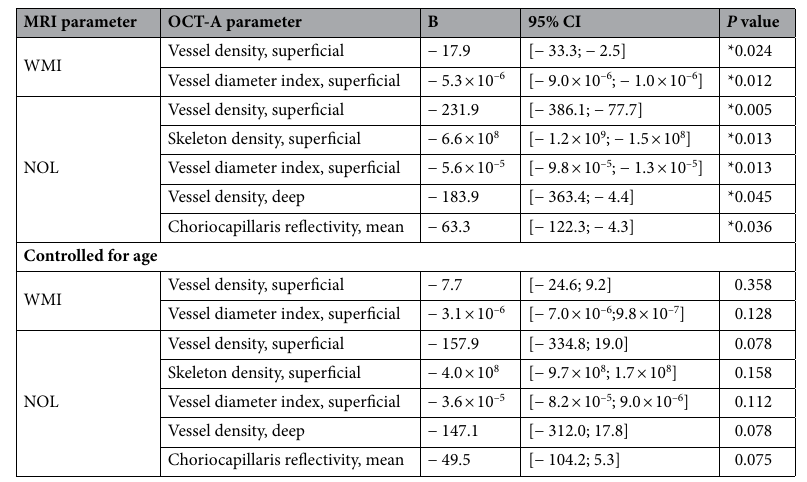
Table 2. Associations of MRI and OCT-A parameters for the overall sample in multiple linear regression analysis. NOL, number of white matter hyperintensity lesions on magnet resonance imaging; SD, standard deviation; WMI, White Matter Lesion Index. The numbers are marked with asterisks to highlight statistical significance.